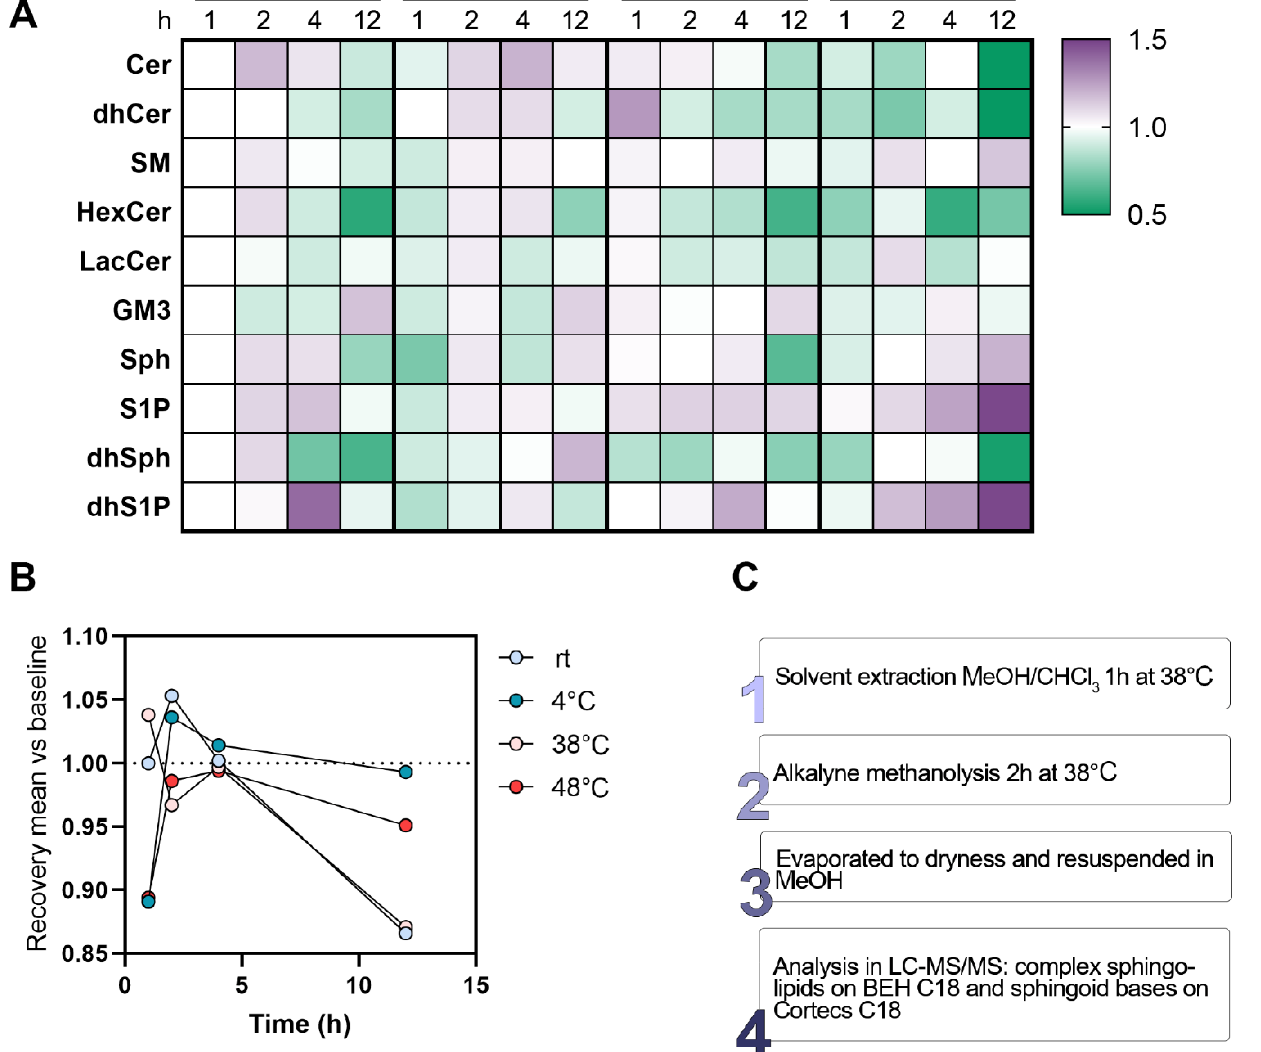
Figure 2. ( A ) Effects of time (1/2/4/12 h) and temperature (rt/4/38/48 °C) on the recovery of sphingolipids from plasma using a single-phase extraction ( n = 2 per each condition). Data were scaled for visualization on the recovery obtained for 1 h at rt (22 °C). ( B ) The effects of times (1/2/4/12 h) and temperatures (room temperature, rt/4/38/48 °C) on the recovery of sphingolipids from plasma. Data were scaled for visualization on the recovery obtained for 1 h at rt (22 °C, baseline). ( C ) Scheme of the final steps included in the protocol